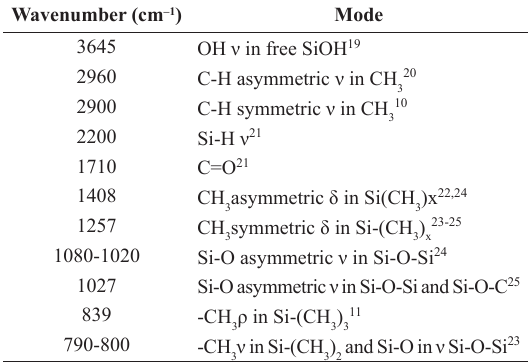
Table 1. Absorption bands detected in the infrared spectra of plasma-polymerized films from pure HMDSO or using equal in the gas proportions of HMDSO and O 2